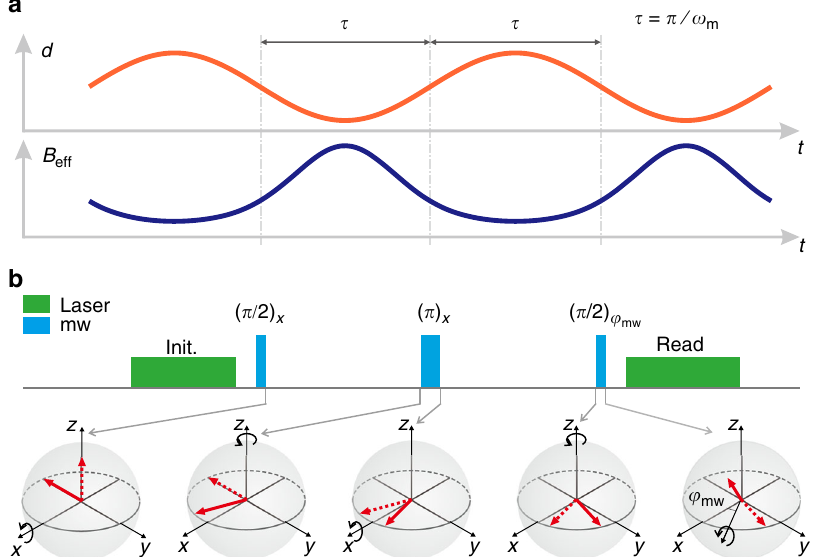
Fig. 2 Electron – nucleon interaction detection scheme. a Time variation of the distance d (upper) and the effective magnetic fi eld B eff (lower). The distance d is between S and the bottom of M . The waiting time, τ = π / ω m , is half period of the vibration of M , and B eff is the effective magnetic fi eld on S generated by the nucleons in M . b Experimental pulse sequence (upper) and state evolution of S (lower). The pulse sequence applied on S is synchronized with the vibration of M . Green laser pulses were used to initialize and read the state of S . The microwave π /2 and π pulses were applied only when M passed through the equilibrium point of the